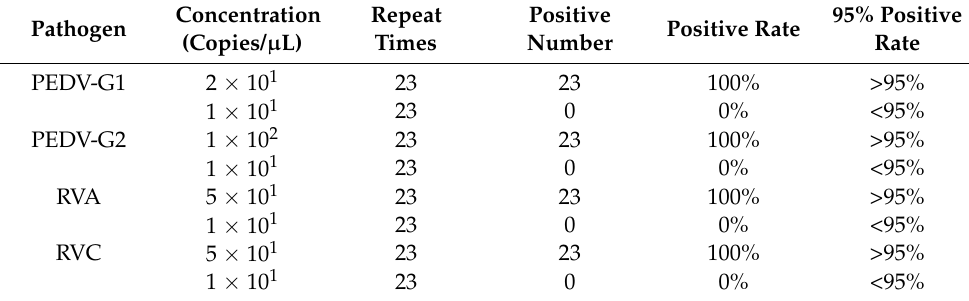
Table 2. Sensitivity of the multiplex real-time PCR assay.